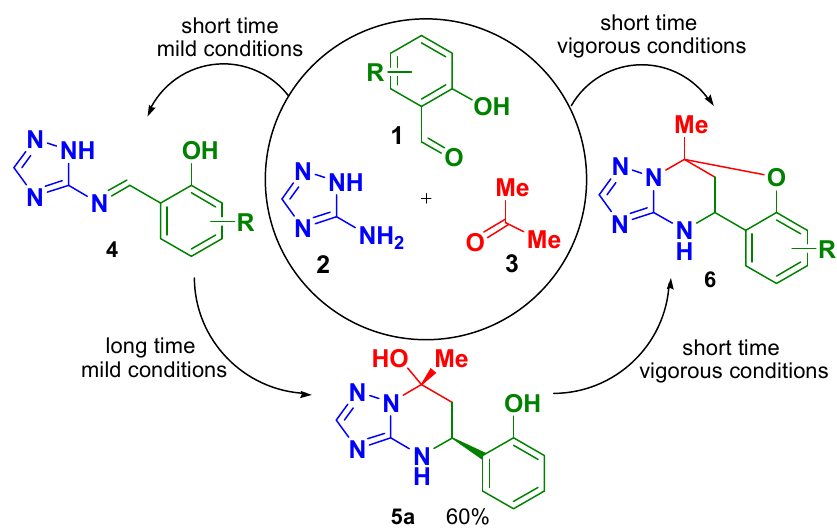
Scheme 1. Different products from the studied multicomponent reaction (MCR).